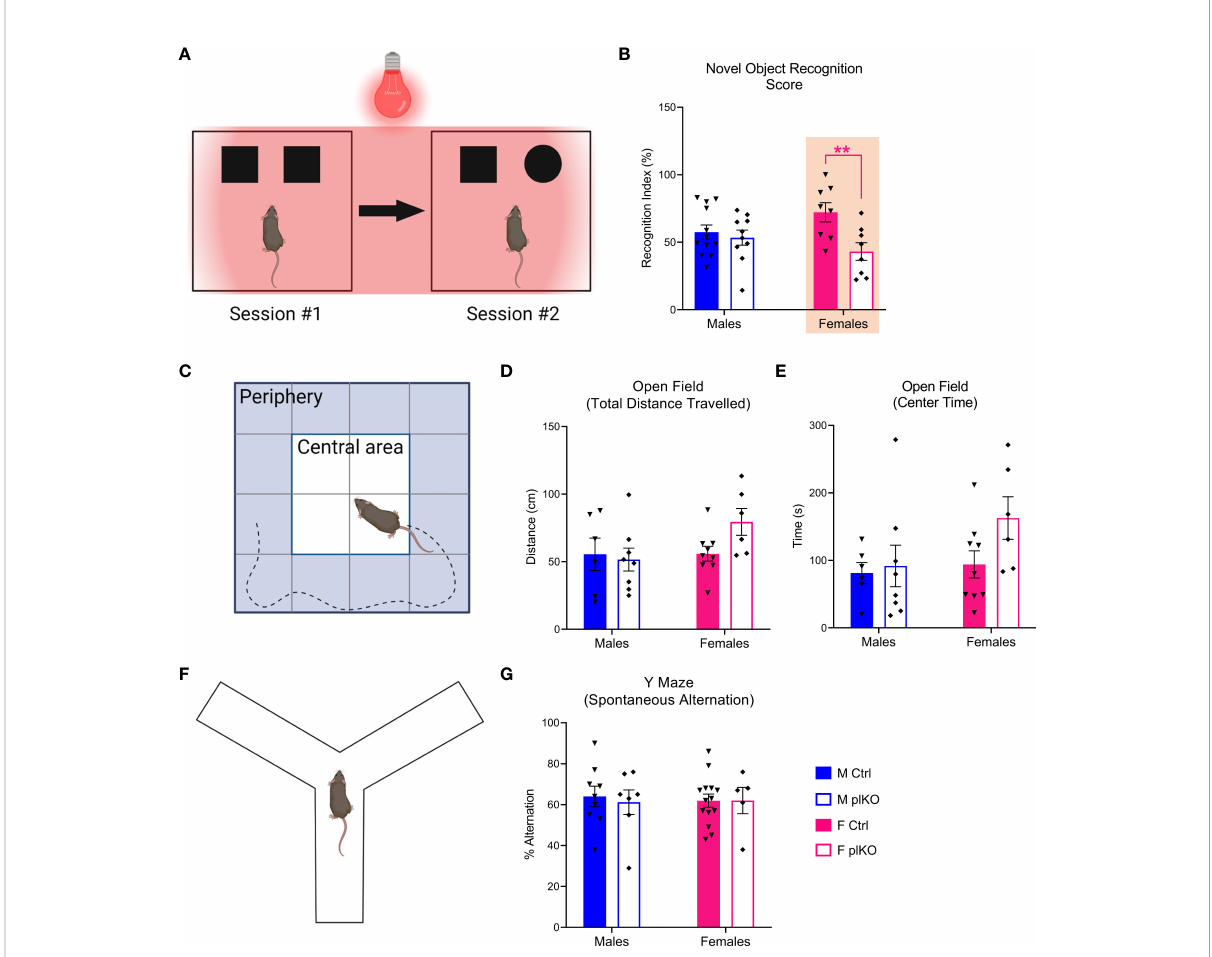
FIGURE 4 Long-term effect of placental ALLO insuf fi ciency on behavior. (A) Schematic diagram of the novel object recognition test, designed to assess the somatosensory function. (B) Female plKO mice have signi fi cant de fi cits in the novel object recognition task, as measured by the recognition index (RI), which corresponds to the ratio between the time spent exploring the new object relative and the total exploration time. n = 12 M Ctrl, 8 F Ctrl, 10 M plKO, 8 F plKO. Data presented as mean ± SEM. (C) Diagram of open fi eld paradigm. (D) Total distance travelled by Ctrl and plKO mice in open fi eld test. (E) Time spent in center quadrants of the open fi eld. n = 6 M Ctrl, 9 F Ctrl, 8 M plKO, 6 F plKO. (F) Diagram of alternating Y-maze. (G) Alternation score (# alternations/# of possible alternations x 100). n = 9 M Ctrl, 14 F Ctrl, 7 M plKO, 5 F plKO. Data presented as mean ± SEM. Two-way sex by genotype ANOVA with Sidak ’ s post-hoc comparison test: * *p < 0.01 identi fi ed in magenta for females. Illustrations in (A, C, F) were prepared using